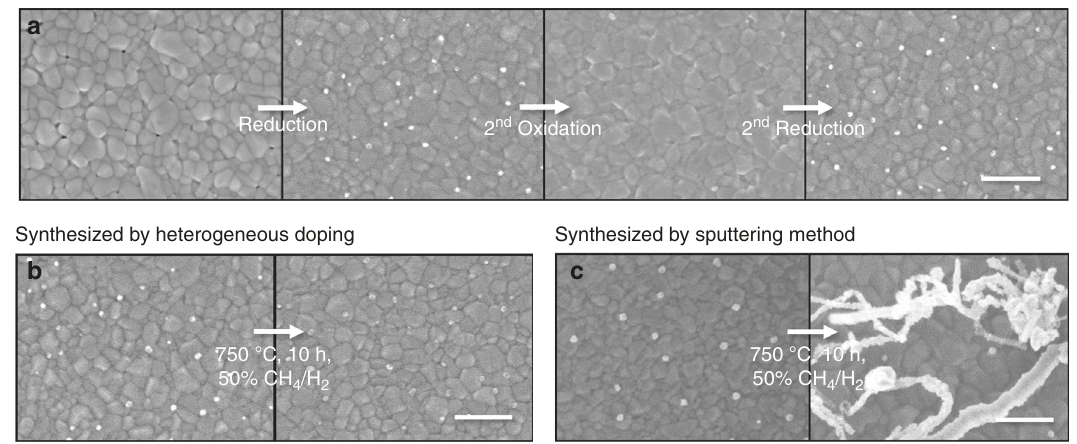
Fig. 5 Regenerating and anti-coking ability of Ni nanoparticles. Field emission scanning electron microscopy (FE-SEM) images of Sm-doped CeO 2 (SDC) surfaces ( a ) according to redox cycles at 700 °C and after exposure to dry CH 4 with Ni nanoparticles synthesized by ( b ) heterogeneous doping and ( c ) sputtering method (scale bars =